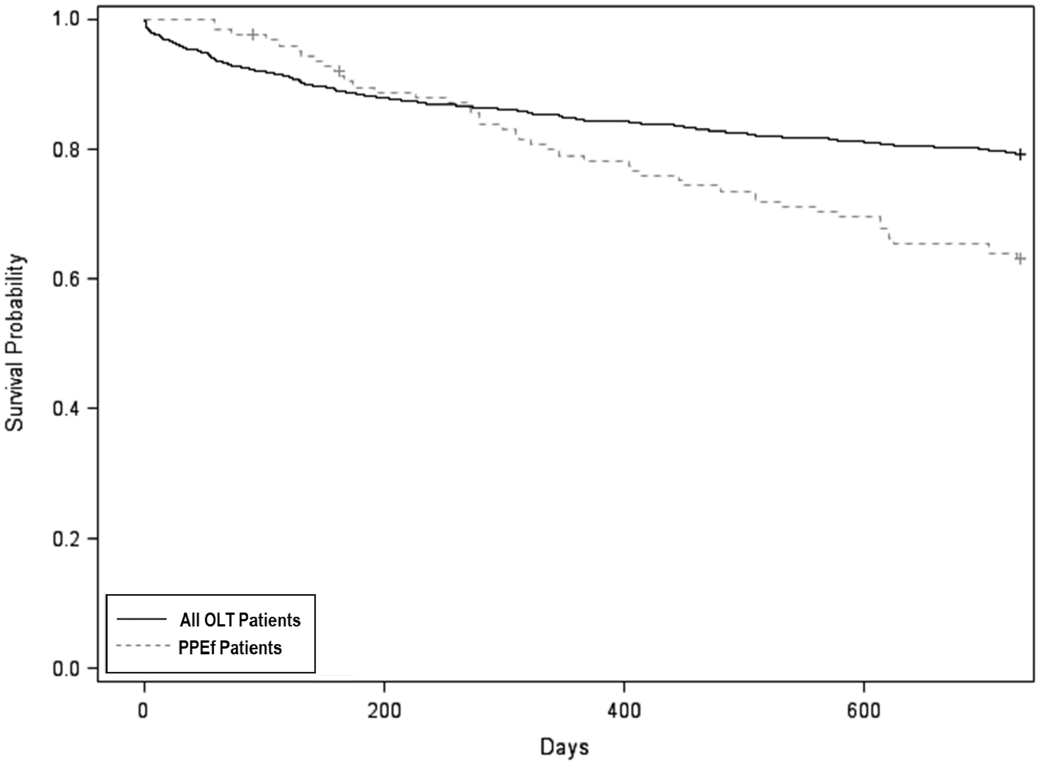
Figure 1. Survival probability: persistent pleural effusion vs. entire liver transplant population. Survival at 2 years was 63.5% for persistent pleural effusion (PPEf) patients versus 79.1% for all orthotopic liver transplant (OLT) patients. When adjusted for age and Model for End-Stage Liver Disease (MELD) score, the hazard ratio for PPEf was 1.63 (95% CI 1.19–2.22, p = 0.002).